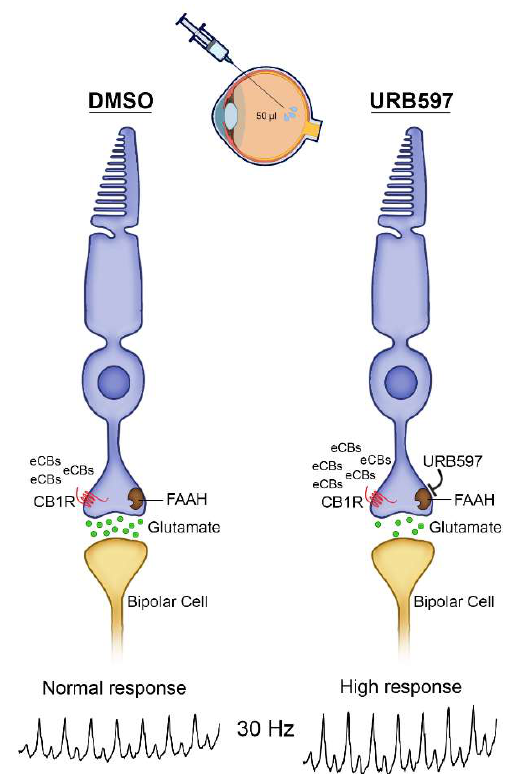
Figure 4. Overview of the putative mechanism of action of URB597 in the monkey retina. CB1R, cannabinoid receptor type 1; DMSO, dimethyl sulfoxide; eCBs, endocannabinoids; FAAH, fatty acid amide hydrolase (brown squares); glutamate (green filled circles); URB597. Methodological considerations. Under light adapted conditions (30 cd/m 2 for ap-